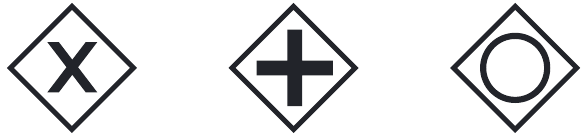
Figure 3. BPMN shapes for message, timer and error events